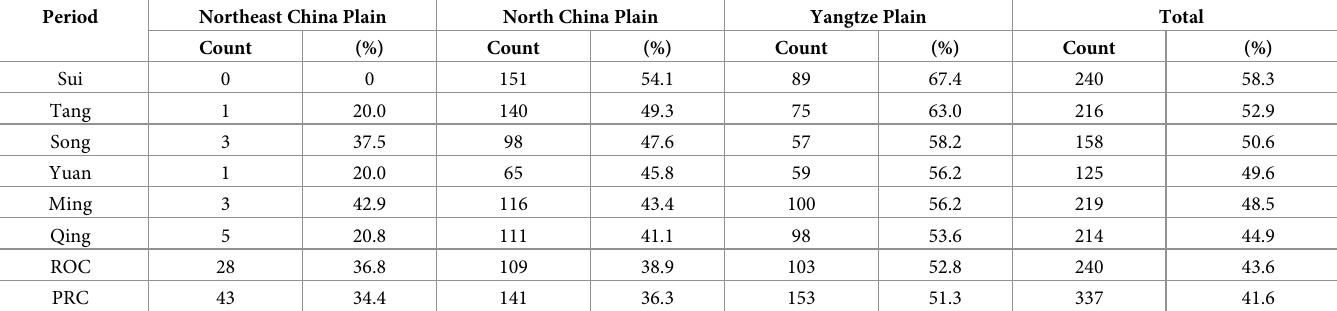
Table 3. Statistical characteristics of county-level administrative toponyms relevant to natural factors since the Sui dynasty.